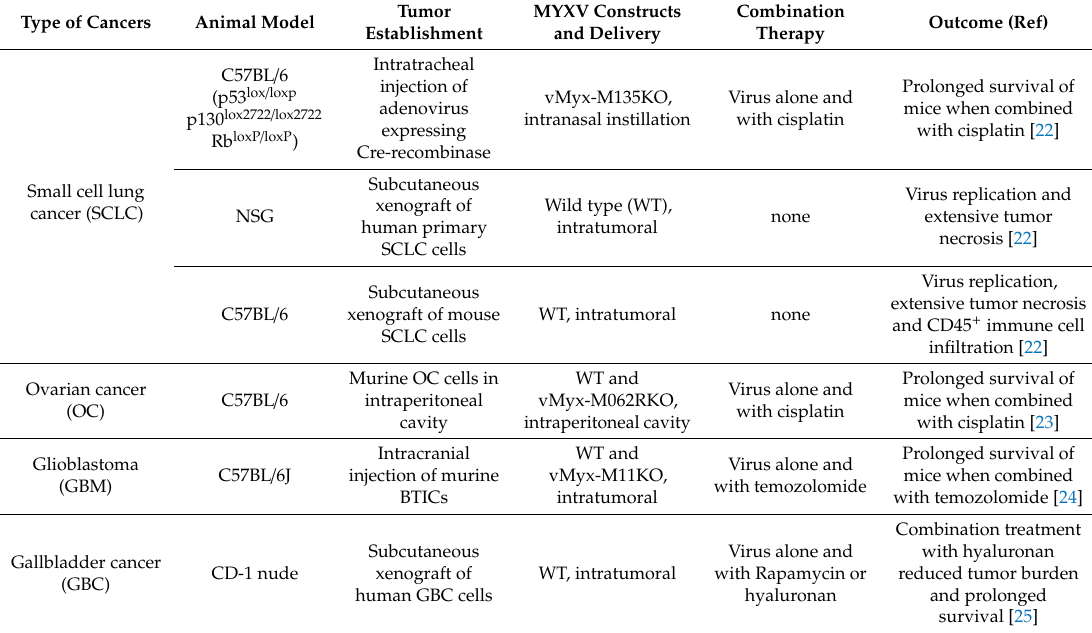
Table 1. Summary of preclinical cancer models tested with oncolytic